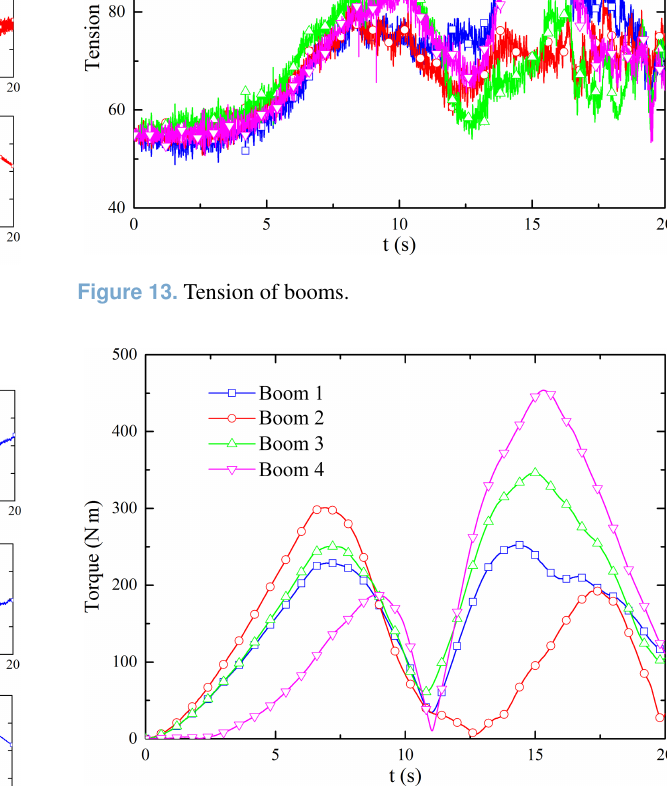
Figure 14. Torque of